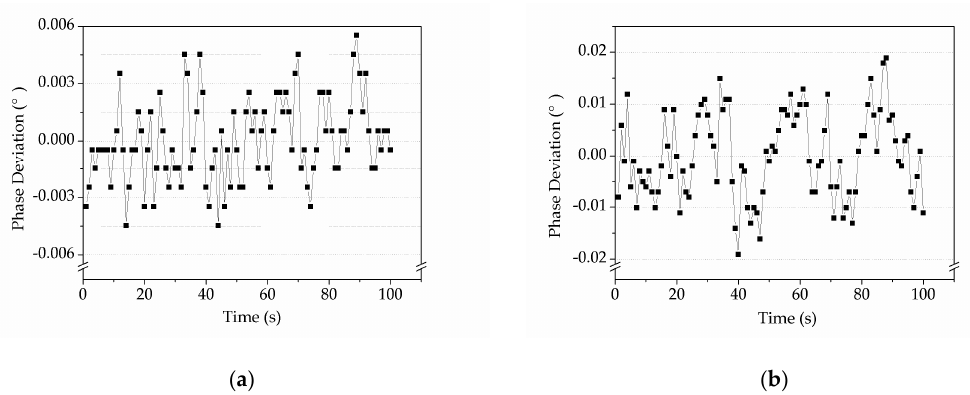
Figure 11. Deviation of the phase detection. ( a ) The phase detection of 100 s measurements for the 10 MHz sine wave was less than 0.006°. ( b ) The phase detection of 100 s measurements for the 50 MHz sine wave was less than 0.02°.